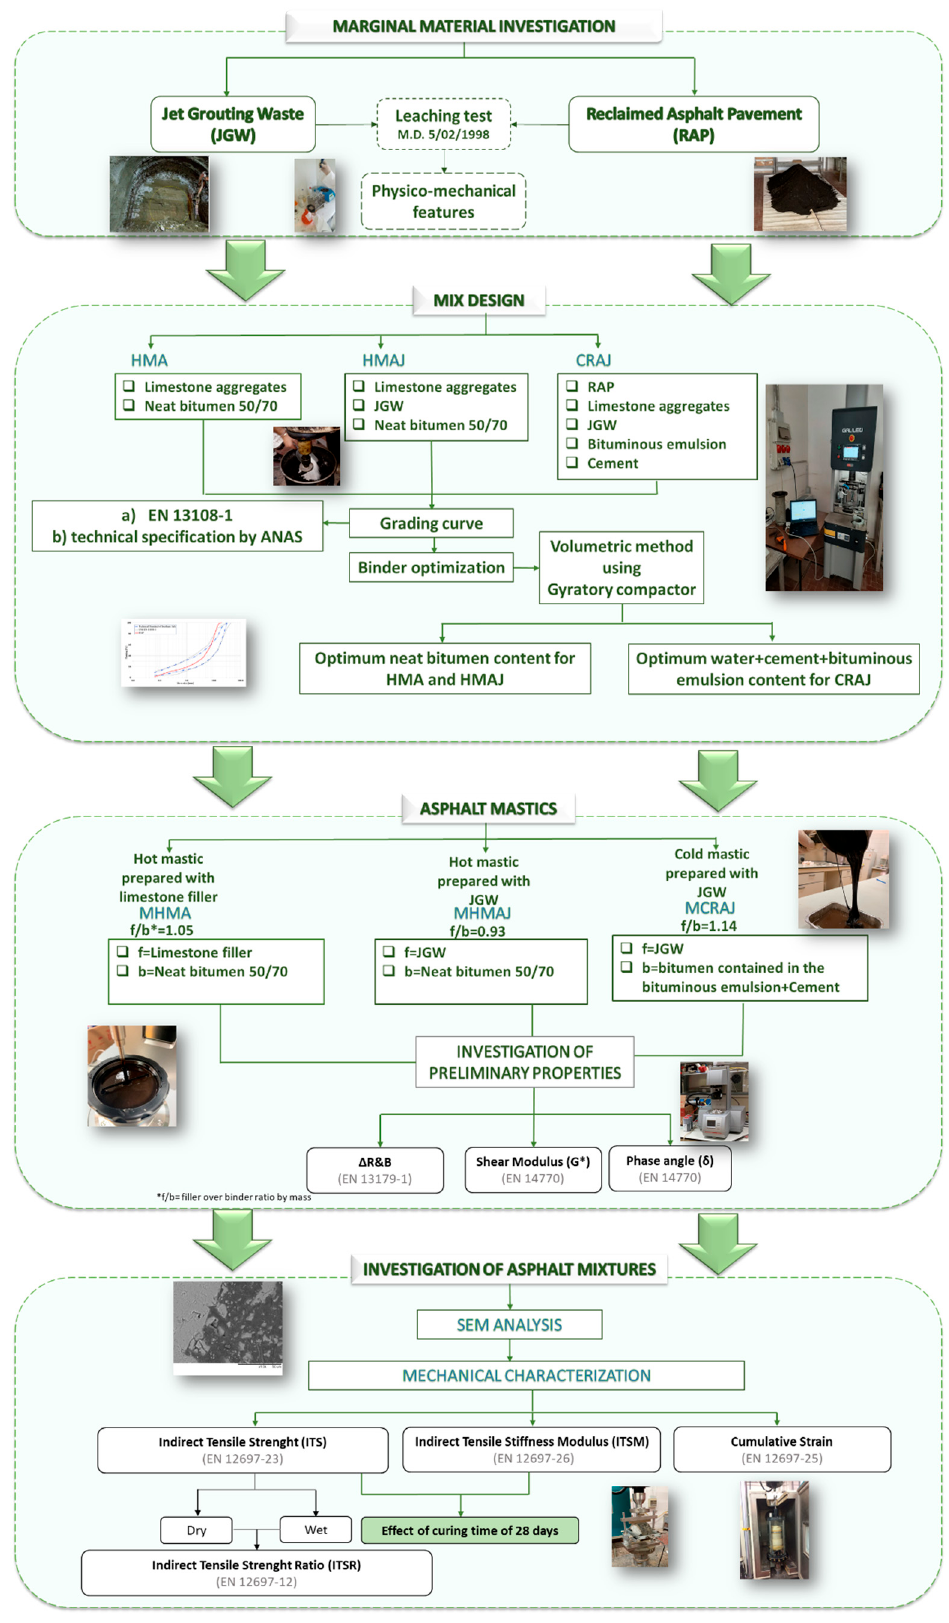
Figure 1. Flowchart of the analysis performed in this study.